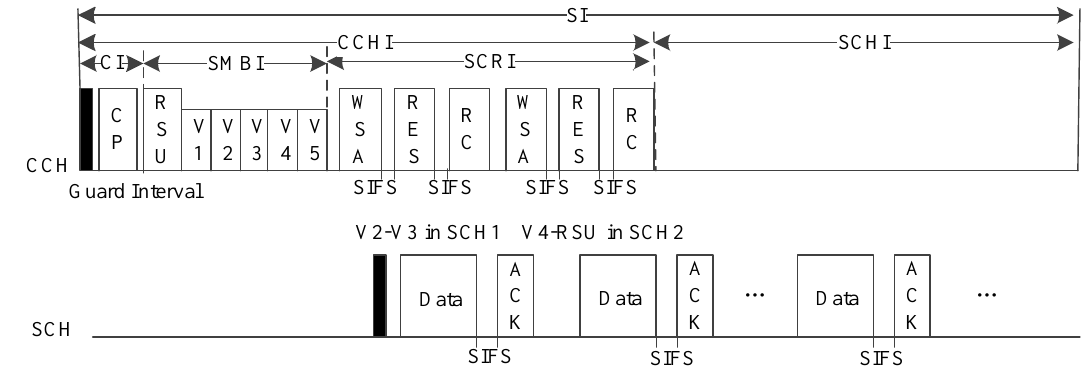
Figure 17. Time structure of IC-MAC.